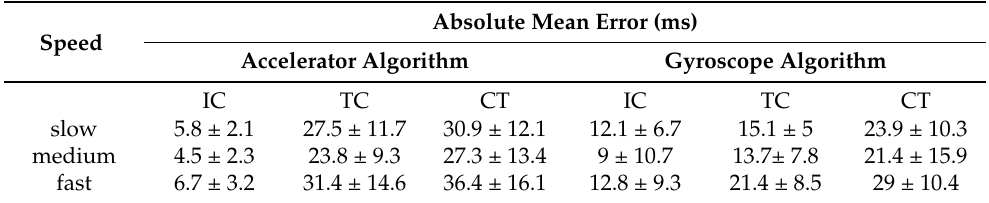
Table 3. The mean error of the two algorithms under different